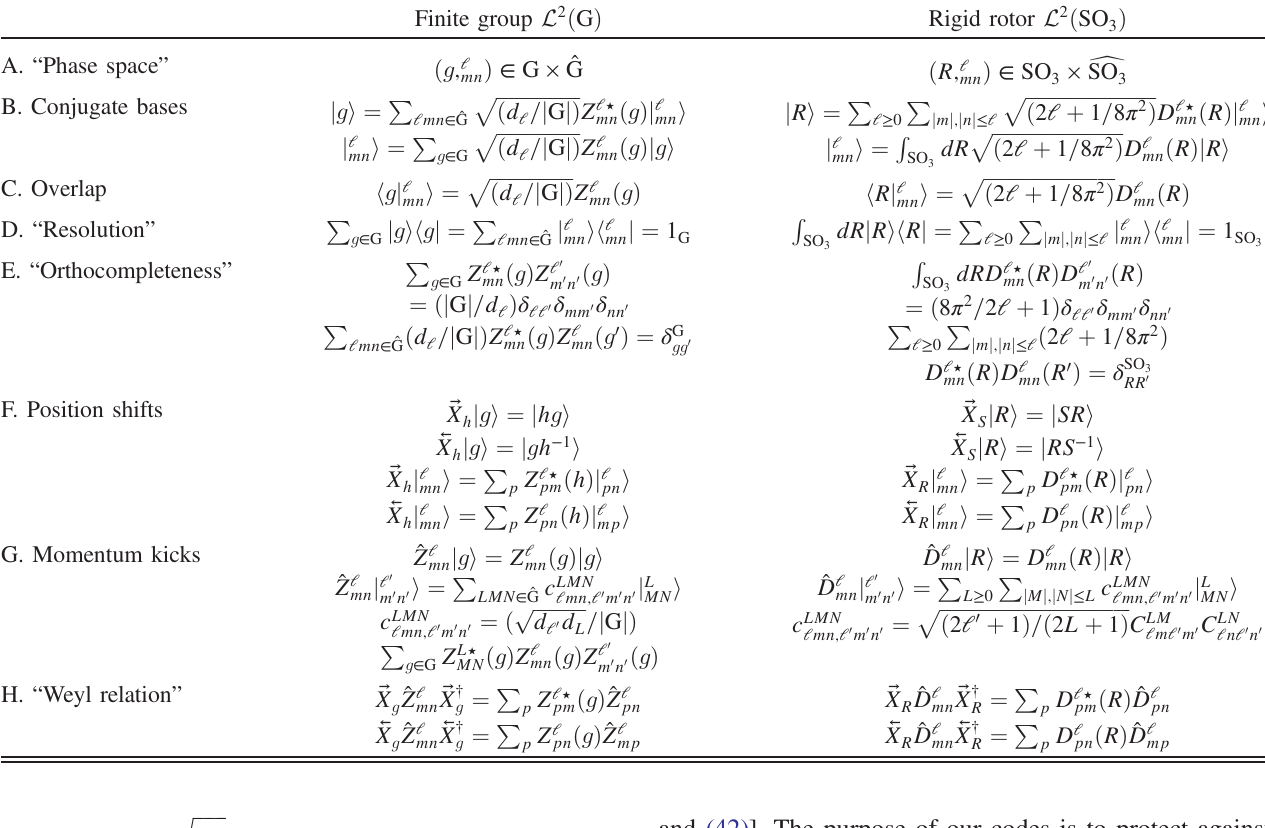
TABLE IV. Summary of relations for L 2 ð G Þ — the space of L 2 -normalizable functions on a group G — extending analogous summaries for ordinary qudit and oscillator state spaces (see Table 1 in Ref. [172]). The C LM l G ¼ Z × n , the state space is that of n qudits, and the position states and their corresponding momentum states are both discrete D orthonormal bases. The rotor state spaces U 1 and SO 3 and, more generally, any continuous compact G admit bases of position states in the continuous or Dirac sense (see Sec. VI. 6 in Ref. [173]). In those cases, ð 1 = j G jÞ volume of G as a manifold and dg is the Haar measure [154]. However, since such spaces are compact, their corresponding momentum bases are still discrete. The oscillator G ¼ R is continuous and noncompact, meaning that both its position and momentum bases are continuous. For this group and others like it, 1 = j G j is omitted, and the sum over l turns into an integral with respect to the Plancherel measure d l [174] (see also Sec. 8.3.3 in Ref.